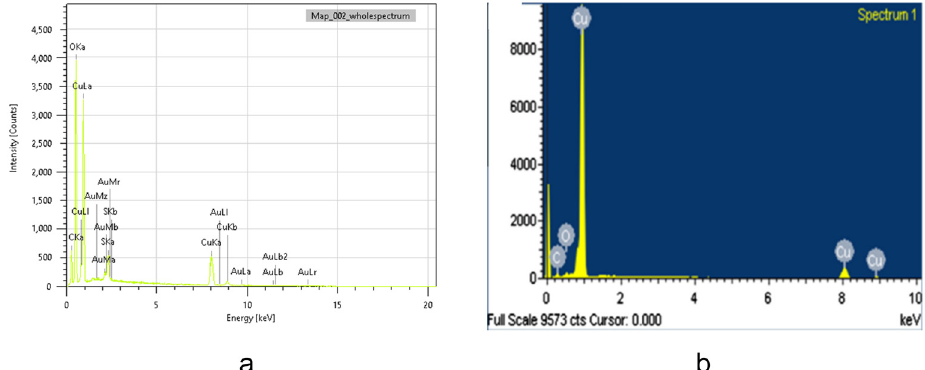
Figure 4: ( a ) Copper oxalate EDX result. ( b ) copper EDX